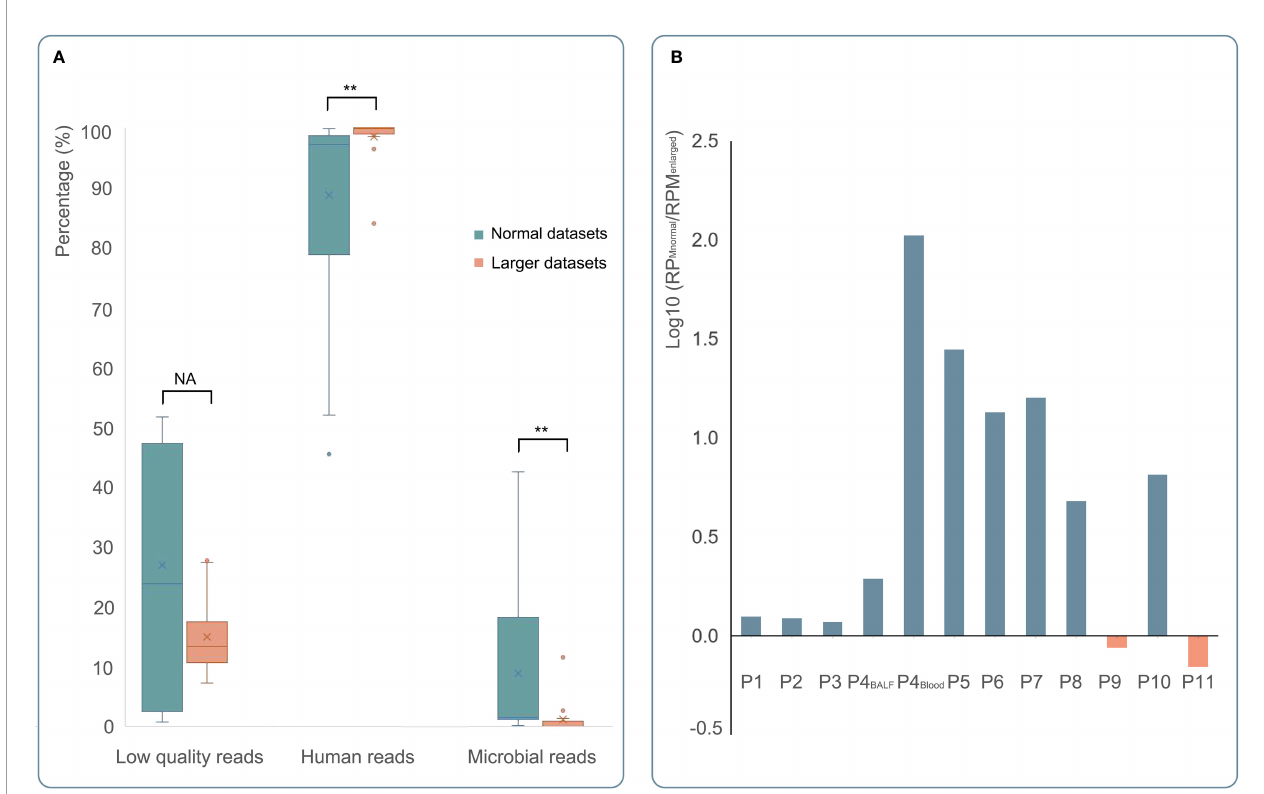
FIGURE 4 | The comparison of mNGS detection results with normal or larger datasets. (A) The results of mNGS with normal datasets and larger datasets were shown in green and orange, respectively. After enlarging the datasets of mNGS, the content of human DNA increased signi fi cantly ( p < 0.01), and the mNGS ef fi ciency (the percentage of microbial reads) decreased signi fi cantly ( p < 0.01). (B) Except three blood samples (one was positive by mNGS with normal datasets); the remaining detection results of 12 samples showed positive by mNGS with larger datasets. Compared to mNGS with normal datasets, a decreased RPM of C. psittaci was found in 10 samples (blue bar). Only two samples (orange bar) showed a little higher RPM by mNGS with larger datasets. *p < 0.05, **p < 0.01 , and NA p >